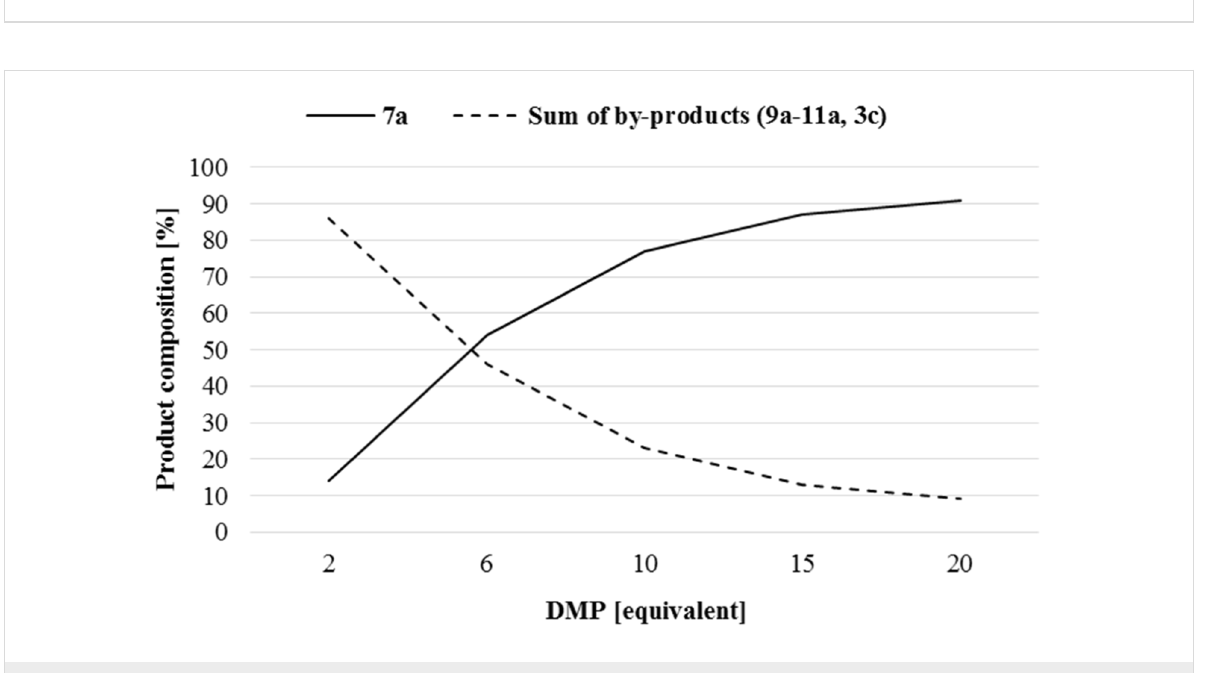
Figure 1: Effect of the quantity of dimethyl phosphite (DMP) on the product composition (from Table 6, entries